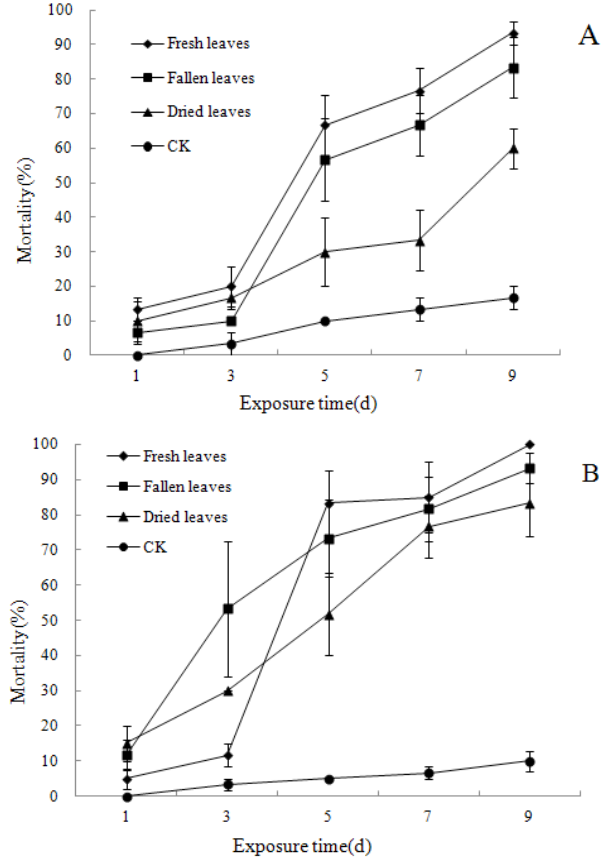
Fig 1. Mortalities of workers (A: major workers, B: minor workers) after treated with different mashed leaves of M.